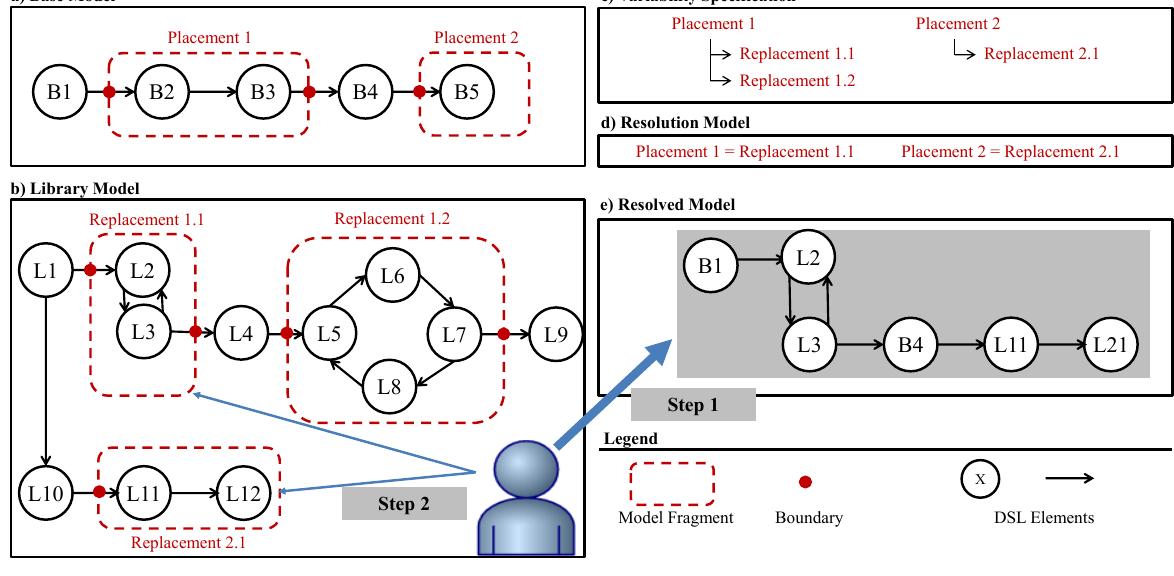
Figure 4. Visualization task